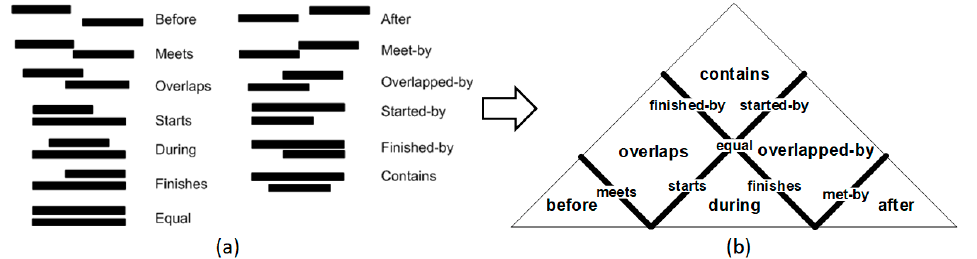
Figure 2. Representing temporal relations in the TM. ( a ) Thirteen topological relations between time intervals. ( b ) The representation of the temporal relations in the TM. (adapted from [15]).